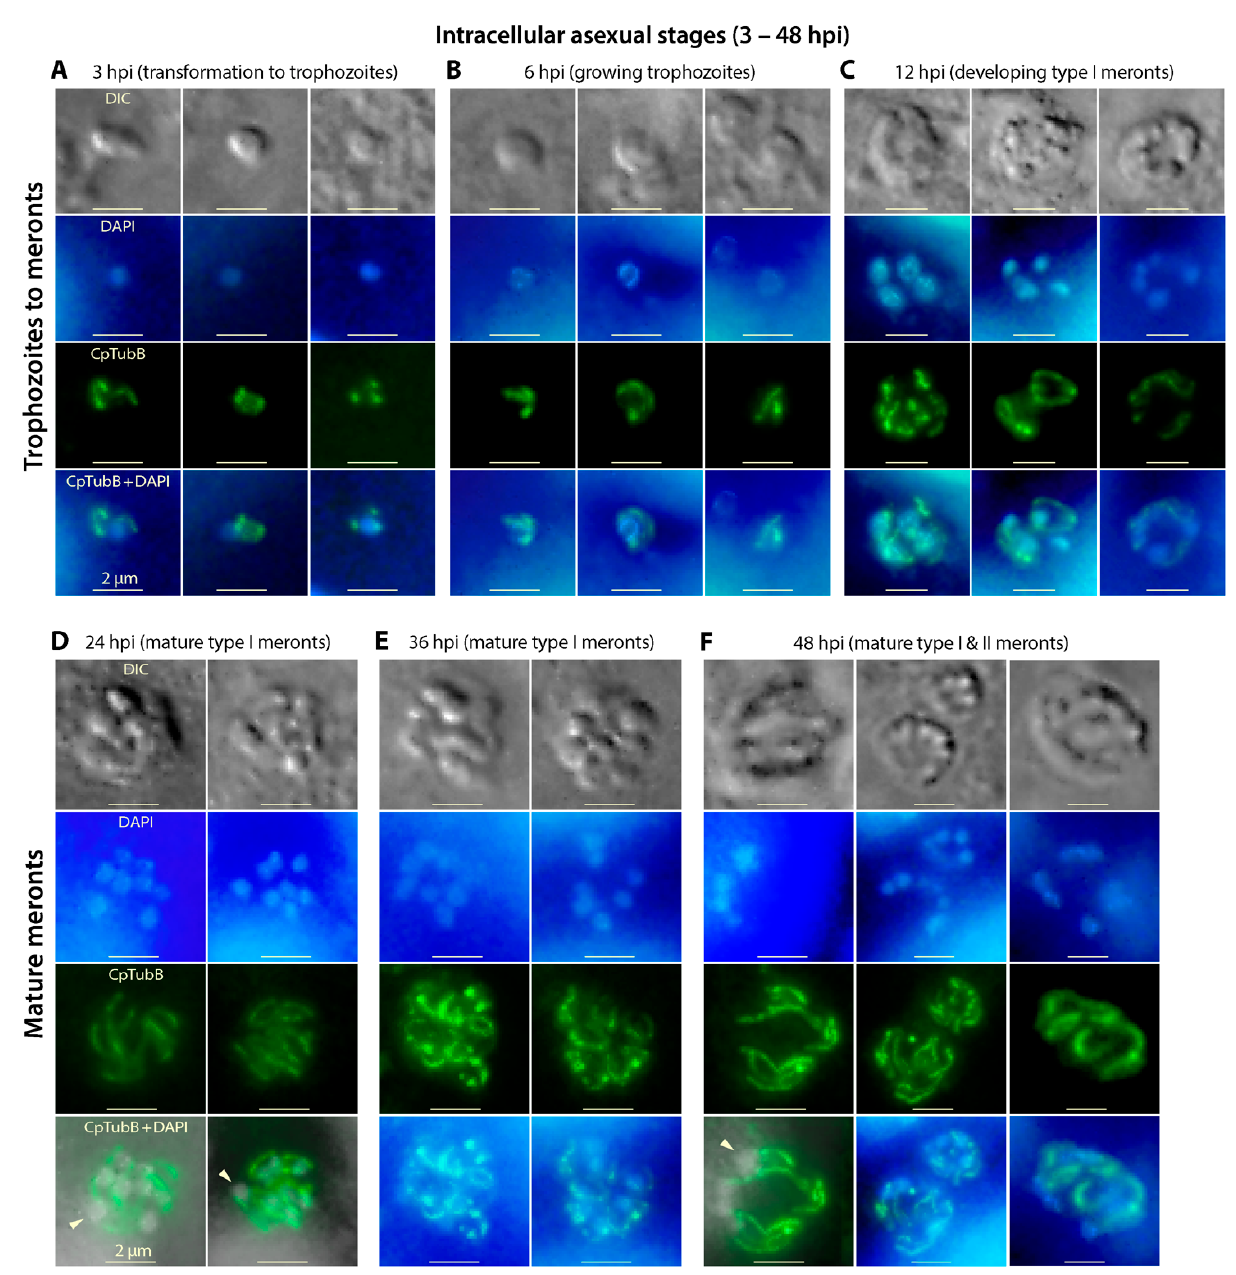
Figure 5. IFA detection of tubulin-based structures in Cryptosporidium parvum during various intracellular asexual devel- opmental stages. Panels ( A – F ) show the intracellular parasites at 3 to 48 h post-infection (hpi), representing transforming sporozoites and transformed trophozoites with one nucleus ( A , B ), developing type I meronts containing four nuclei ( C ) and mature type I and II meronts containing eight or four nuclei, respectively ( D – F ). Microtubules were labeled by anti-CpTubB antibody (green), while nuclei were stained by 4 ′ ,6-diamidino-2-phenylindole (DAPI) (blue). In the merged images of panels ( D , F ), blue nuclei were converted to grey for better visualization (pointed by arrowheads). DIC, differential interference contrast microscopy.